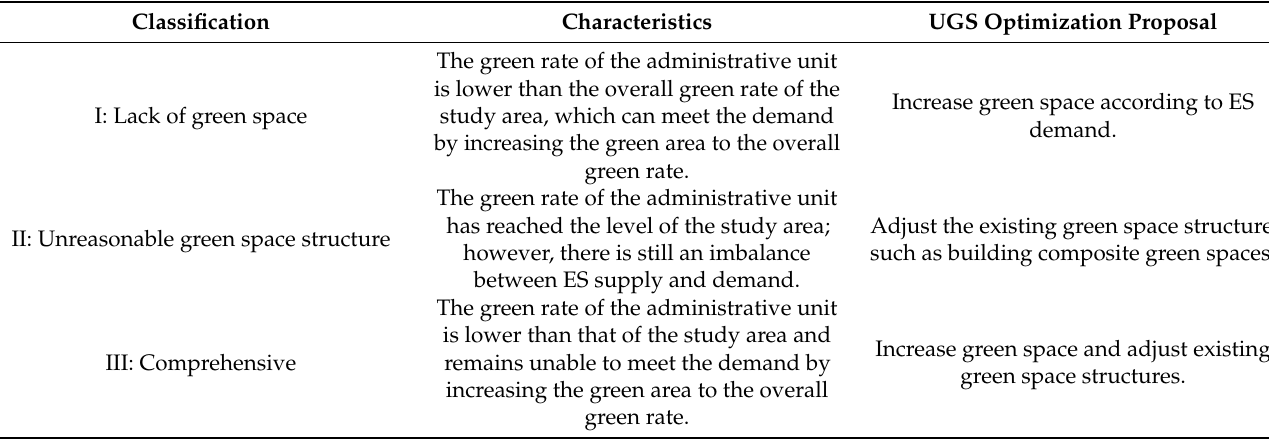
Table 2. Classification of administrative units with unbalanced ecosystem services (ESs) and suggestions for urban green space (UGS) optimization. Classification Characteristics UGS Optimization Proposal